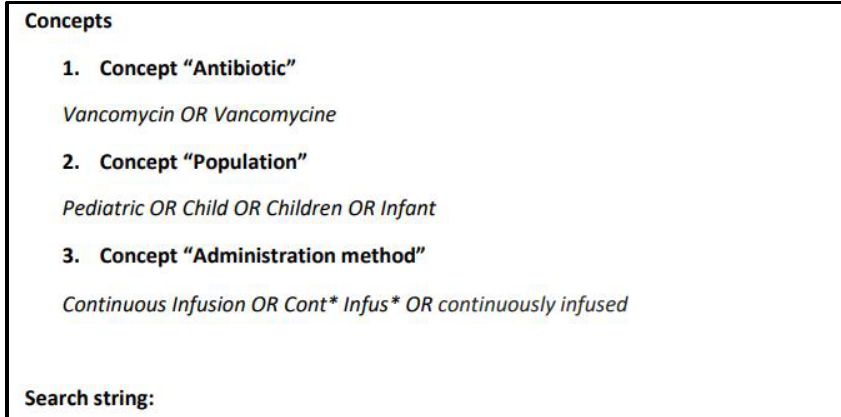
Figure 2. Search